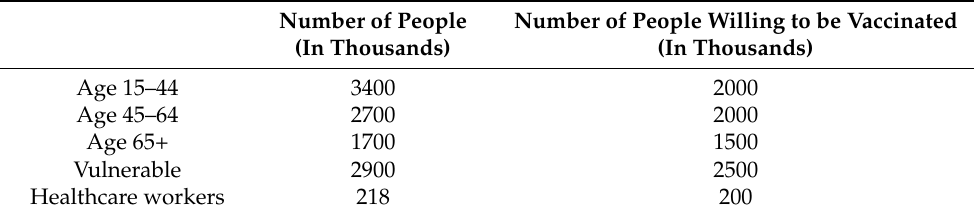
Table A1. Vaccination participation rates by age groups [43–46].